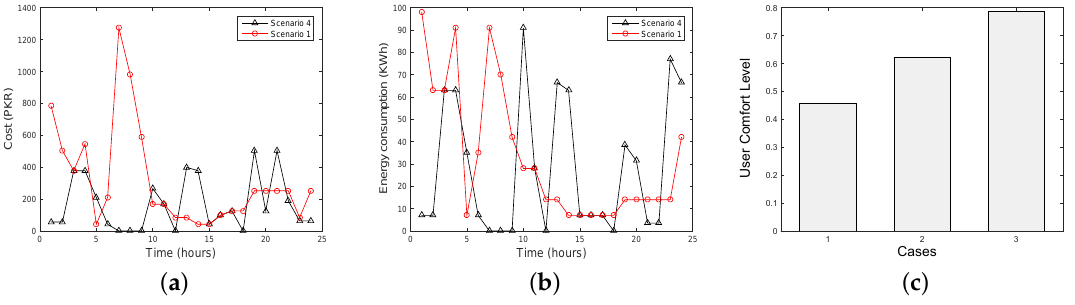
Figure 8. EMS: by using a combination of sensors and the evolutionary algorithm (Scenario 4). ( a ) Cost profile (Scenario 4); ( b ) load profile (Scenario 4); ( c ) UCL when: Case 1: α , ζ = 0.3,0.7; Case 2: α , ζ = 0.5,0.5; Case 3: α , ζ =